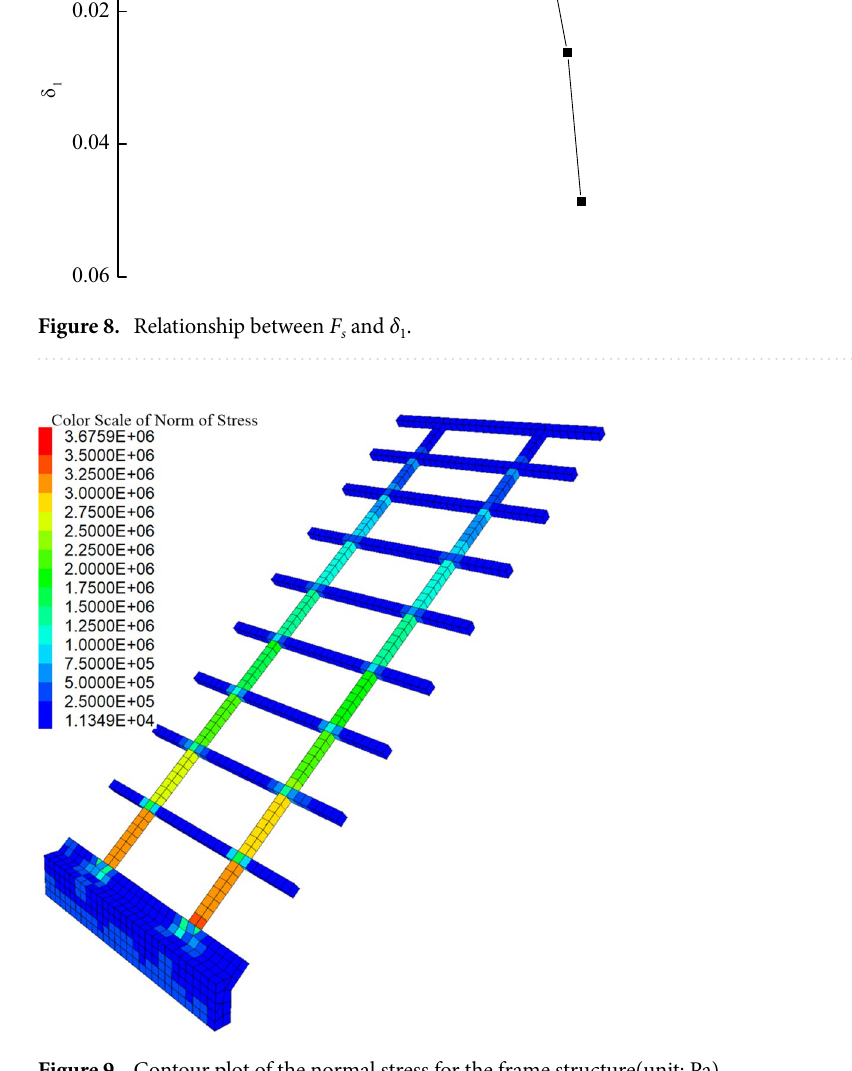
Figure 9. Contour plot of the normal stress for the frame structure(unit: